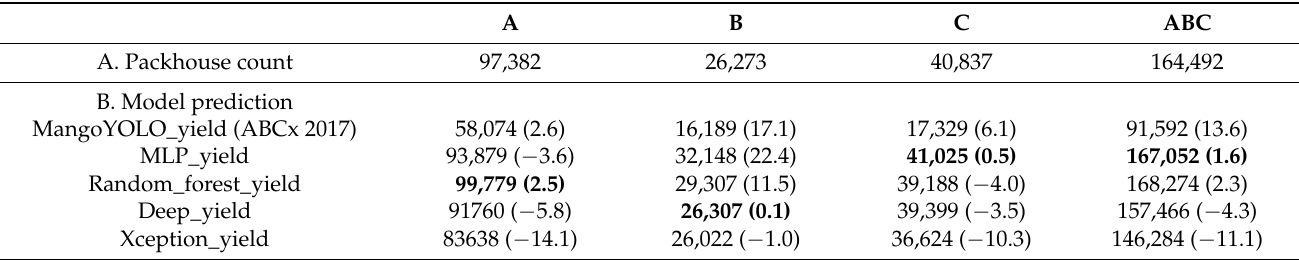
Table 13. Yield estimation results for prediction of fruit load per orchard block, relative to packhouse count. (A) Packhouse count for fruit number of whole orchards, A, B and C, for season 2017. (B) Prediction results for fruit number of whole orchards, A, B and C, for season 2017 from models trained on orchard ABC-x 2017 data. Value in brackets is the percentage error. Best result (closest to packhouse) is shown in